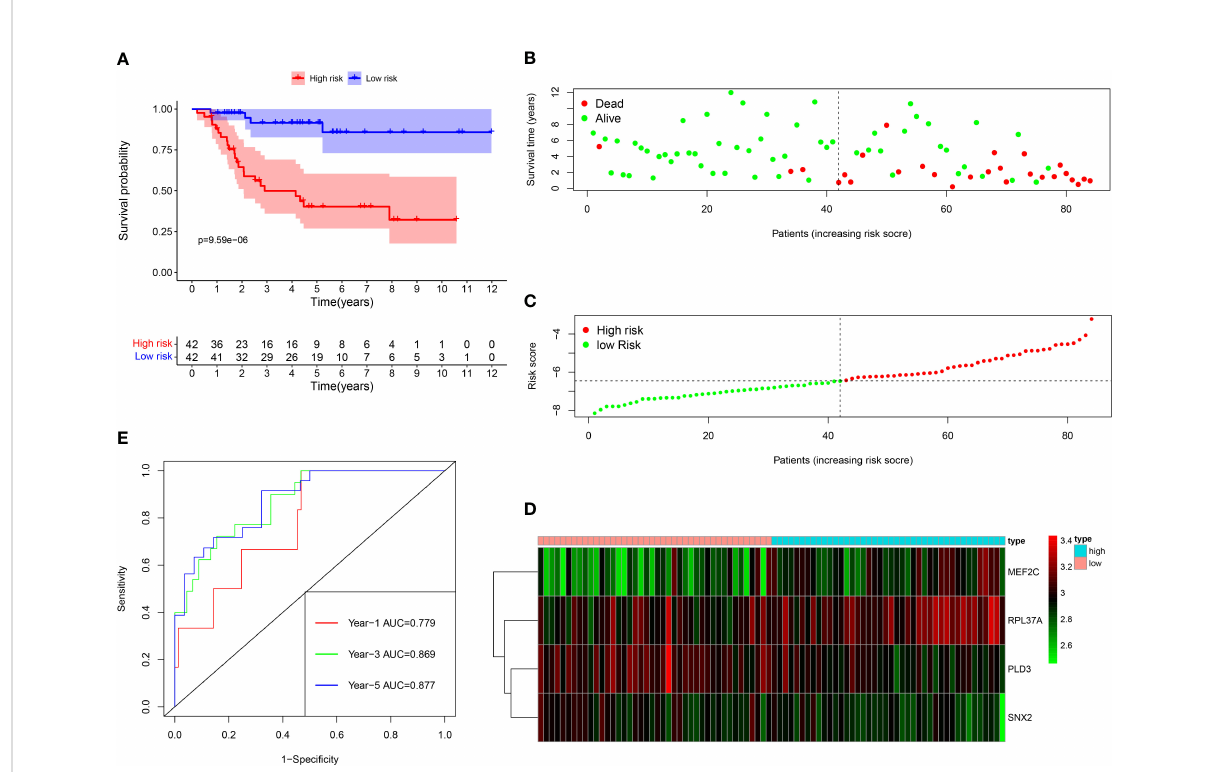
FIGURE 4 Survival analysis results of a risk ‐ scoring model for TCGA osteosarcoma patients. (A) Kaplan – Meier survival analysis of TCGA osteosarcoma patients in high ‐ risk and low ‐ risk groups. (B) The overall survival rate and the survival status of TCGA osteosarcoma patients. (C) The distribution of risk scores for each patient. (D) The expression levels of these 4 B cell marker genes in the high ‐ risk and low ‐ risk groups. The green color represents low expression, while the red color represents high expression. (E) ROC curve analysis of the risk-scoring model ’ s 1-year, 3 ‐ year, and 5 ‐ year OS. OS, overall survival, ROC, receiver operating